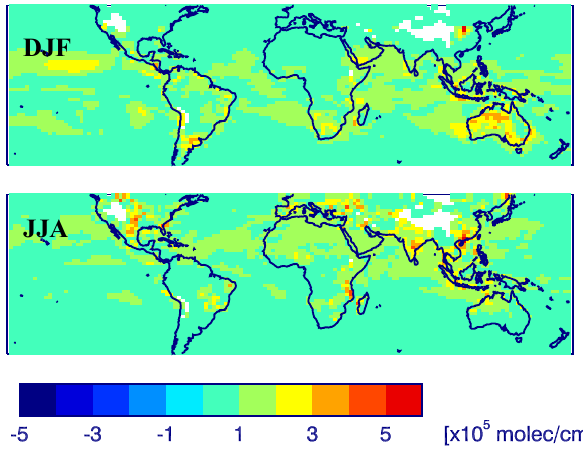
Figure 22. Seasonal mean (1988–2007) standard deviations of OH ( × 10 5 moleculescm − 3 ) at 850mbar for the AllVary